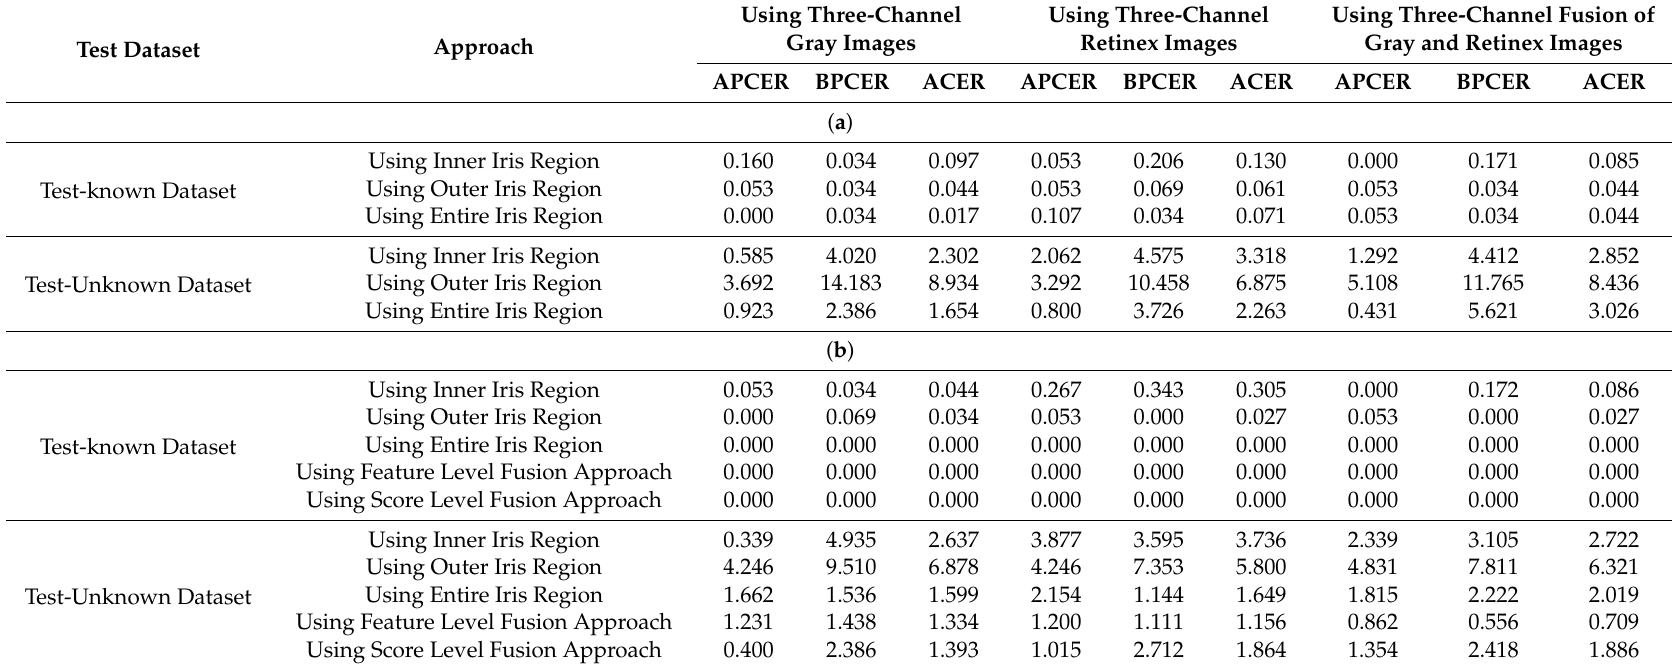
Table 12. (a) Detection errors (APCER, BPCER, and ACER) of iPAD based on CNN method for classification using fusion of Warsaw-2017 and NDCLD-2015 datasets and three kinds of input images (unit: %); (b) Detection errors (APCER, BPCER, and ACER) of iPAD based on SVM method for classification using fusion